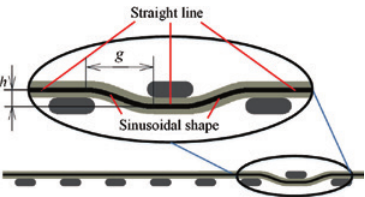
Figure 5: Central line of X tow: a combination of straight and sinu- soidal shape lines.